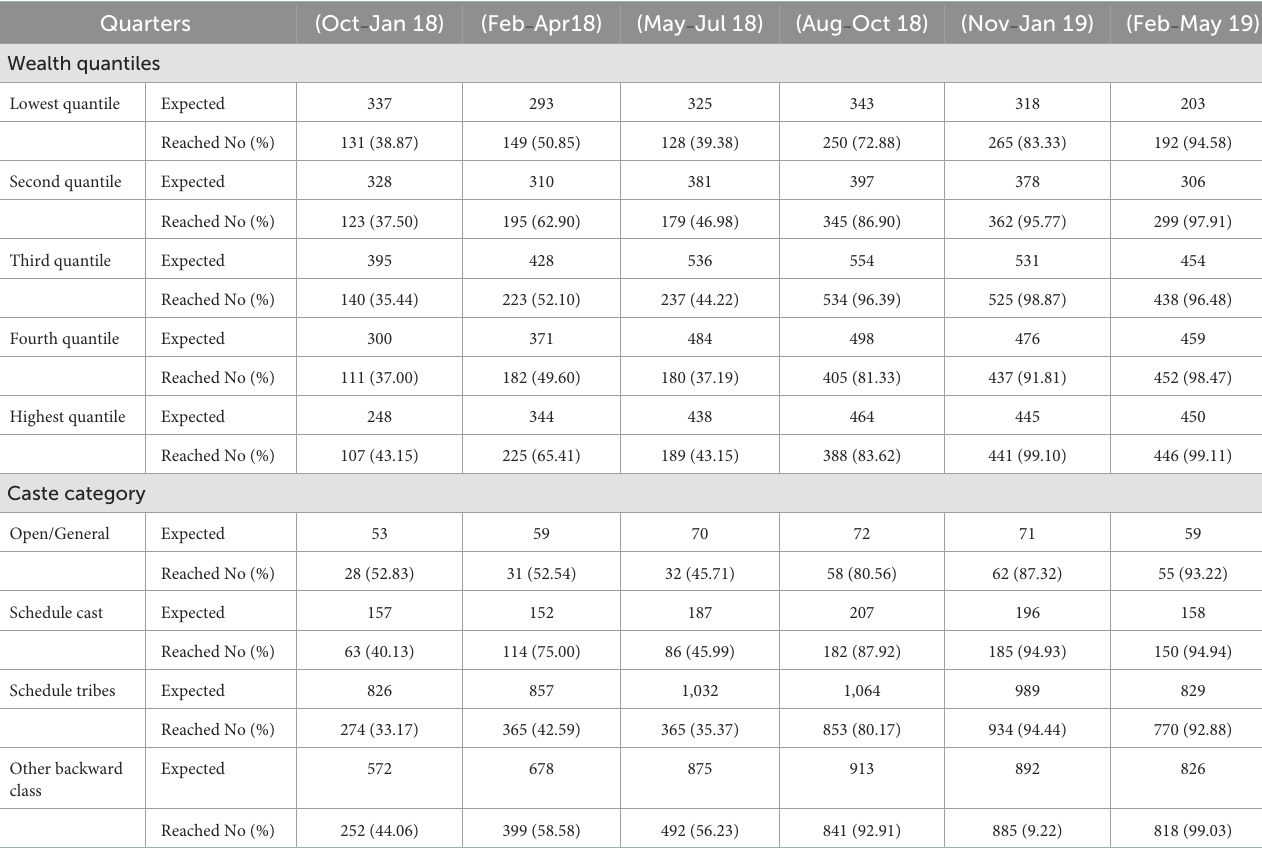
TABLE 2 Intervention coverage in quarterly review cycles with wealth quantiles and caste categories.